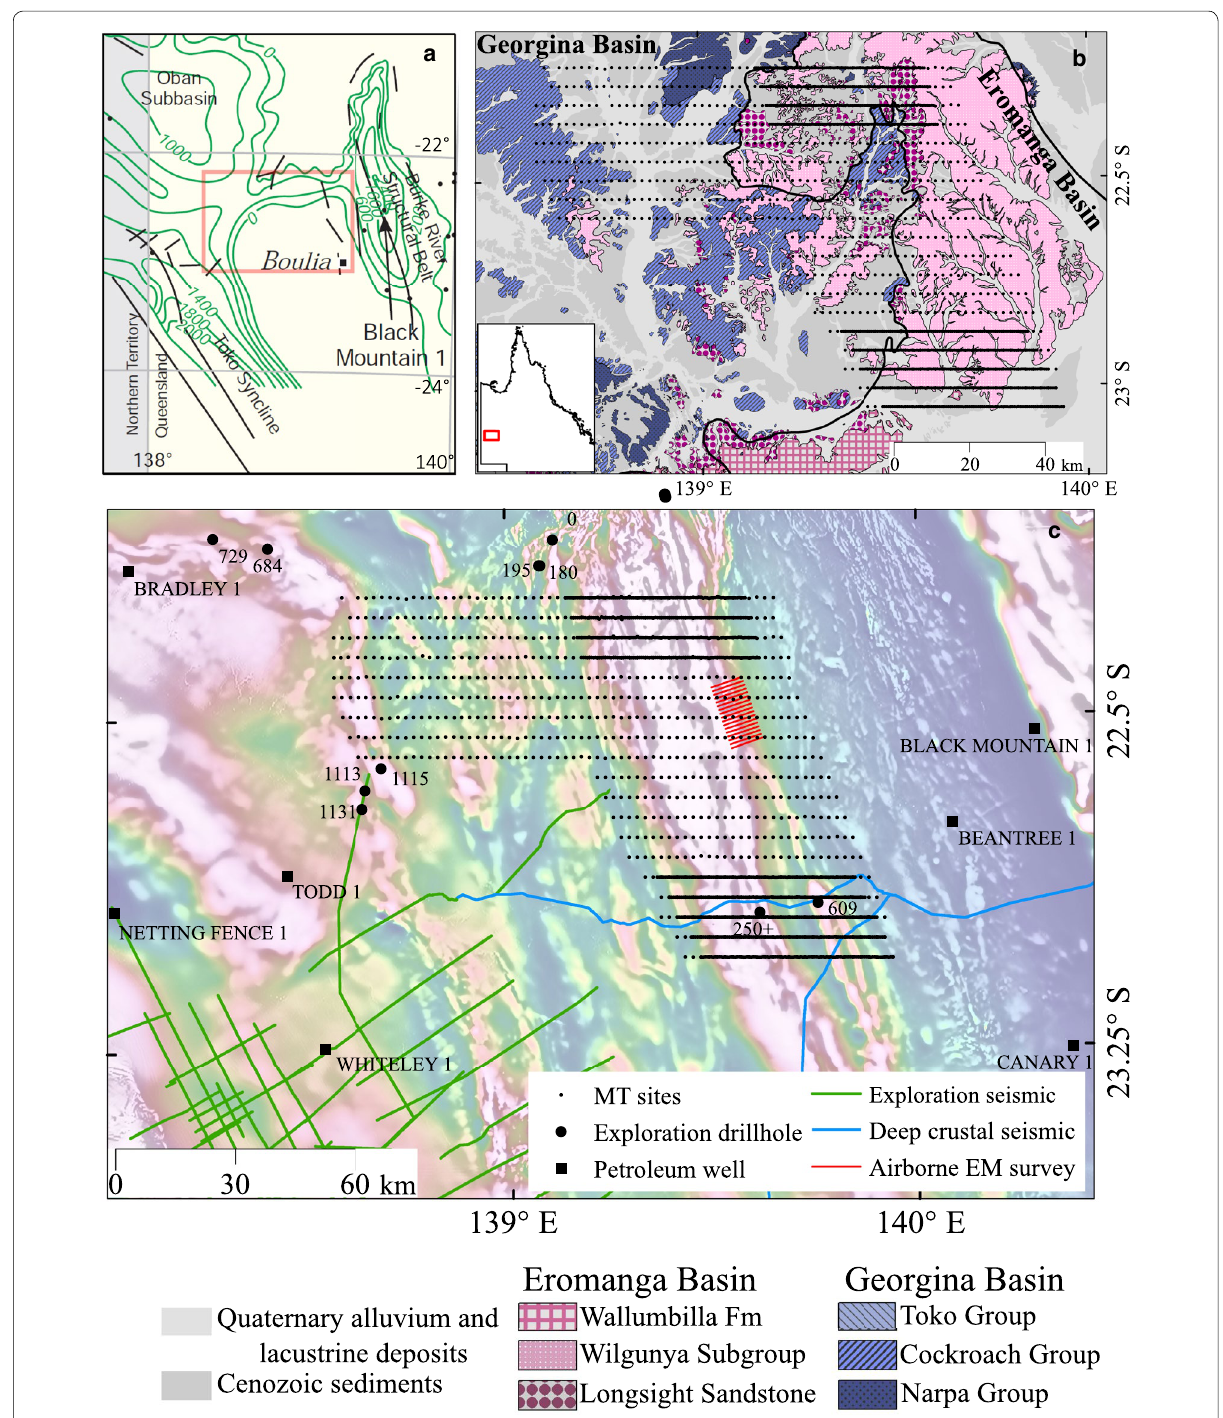
Fig. 1 Summary of mapped surface geology and available constraining information. a Location of the project area in red compared to Georgina Basin subbasins with project area indicated in red [modified after Withnall et al. (2013)]. b Mapped surface geology, thick black line denotes margin of the Eromanga Basin, points are the MT sites used for the study. c Composite first vertical derivative and total magnetic intensity map of the study area showing a north–south strike for the magnetic basement units. Available exploration data for study area also shown, exploration drill holes annotated with intersected basement depths or maximum hole depth where basement was not intersected (indicated by